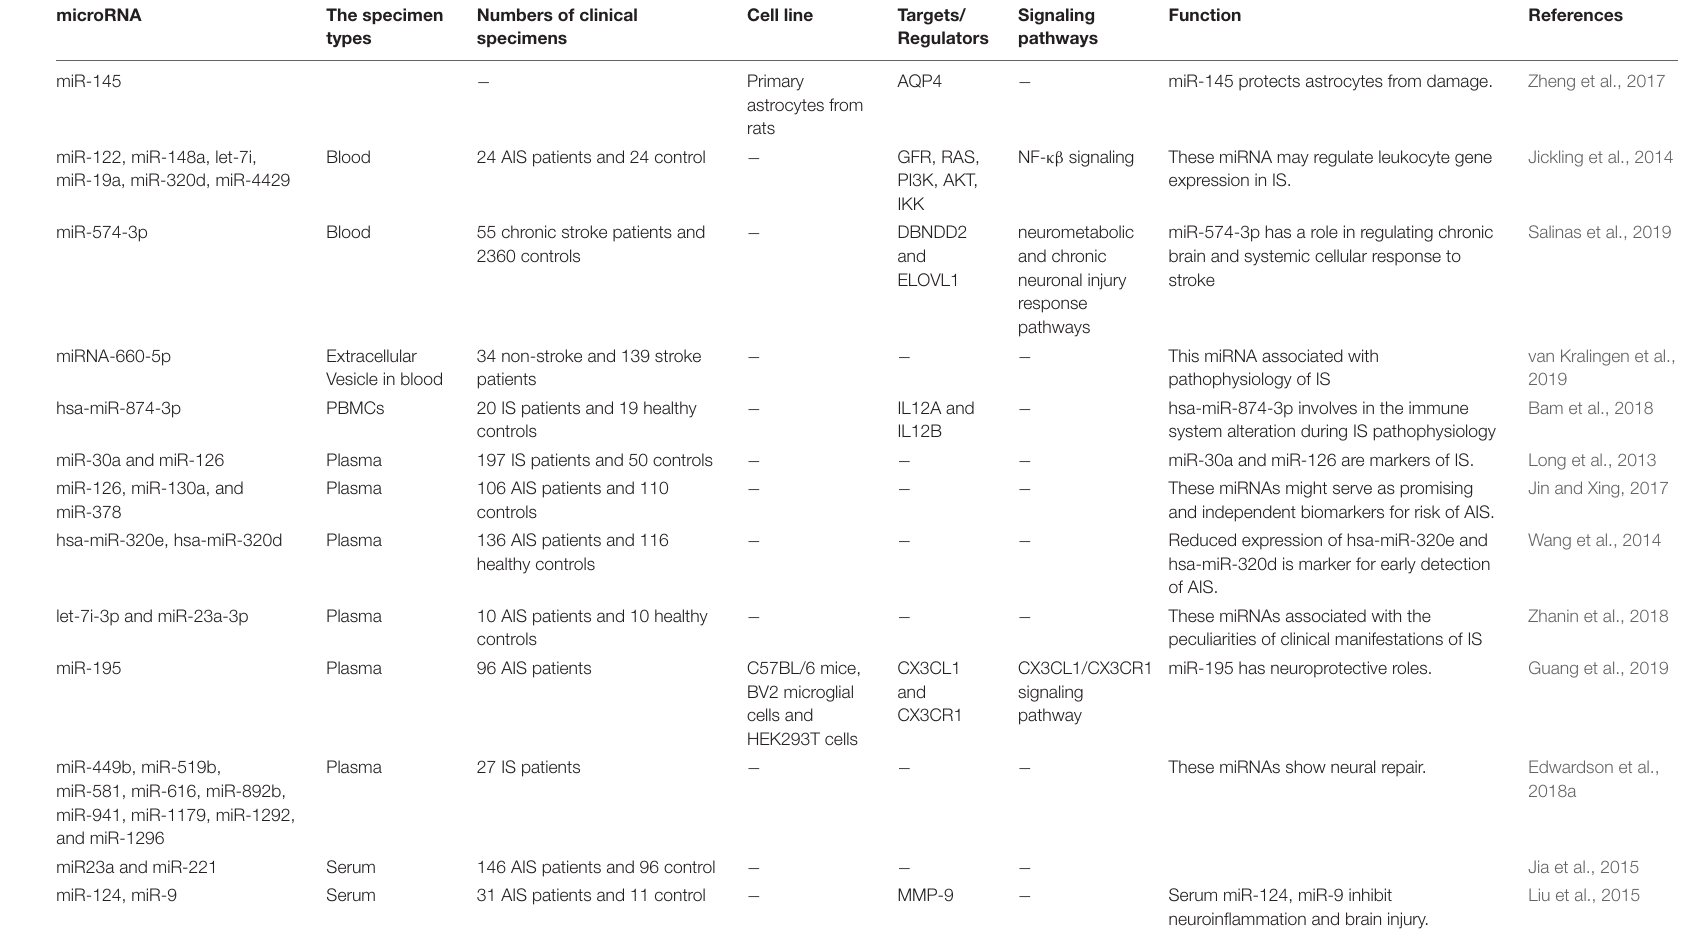
TABLE 5 | Summary of human studies reporting down-regulation of miRNAs in